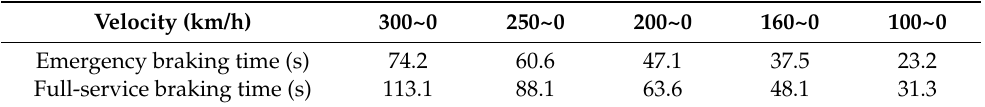
Table 3. Train braking time in train control